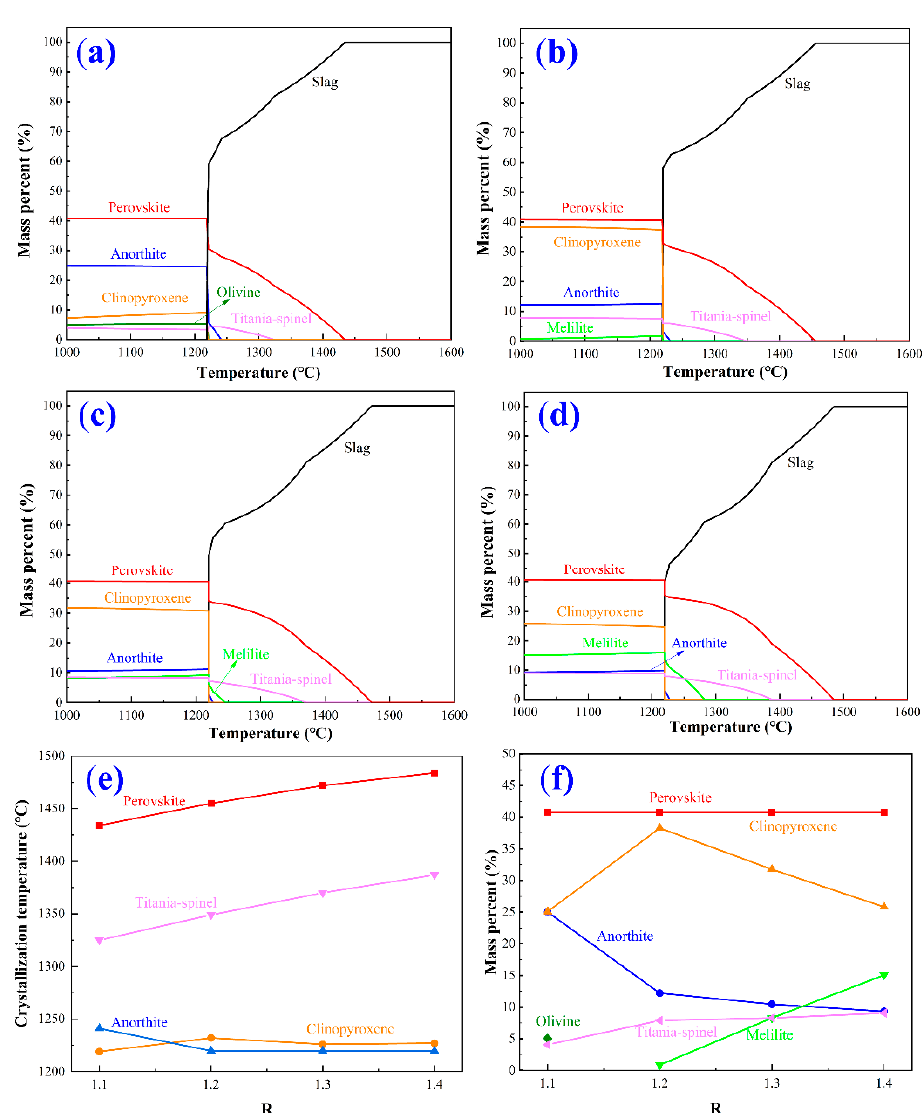
Figure 1. Thermodynamic calculation of TiO 2 -CaO-SiO 2 -Al 2 O 3 -MgO slag precipitation: theoretical phase compositions with basicity of ( a ) 1.1, ( b ) 1.2, ( c ) 1.3, ( d ) 1.4; ( e ) basicity dependence of crys- tallization temperature; ( f ) basicity dependence of mass percent of crystallized phases. (Perovskite-CaTiO 3 , clinopyroxene-Mg 2 Si 2 O 6 , MgAl 2 SiO 6 , CaAlSi 2 O 6 (+), MgAlSi 2 O 6 (+), CaMgAlSiO 6 [ − ], Mg 2 AlSiO 6 [ − ], olivine-Mg 2 SiO 4 , anorthite-CaAl 2 Si 2 O 8 , titania-spinel-MgAl 2 O 4 ).